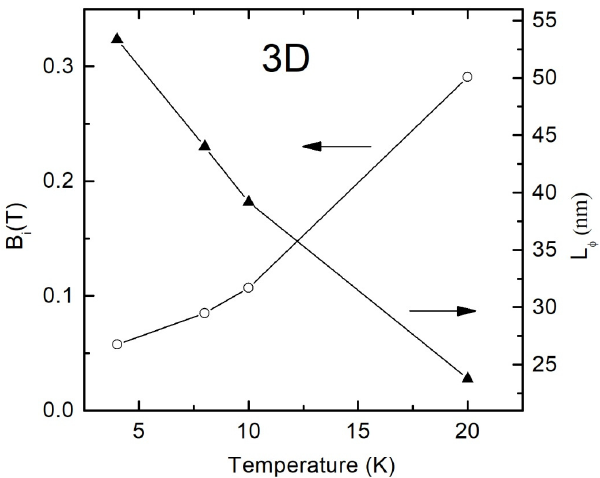
Figure 8. Magnetoresistivity at various temperatures of polycrystalline SnO 2 − δ (sample B). Solid lines are fits by Formula (8).